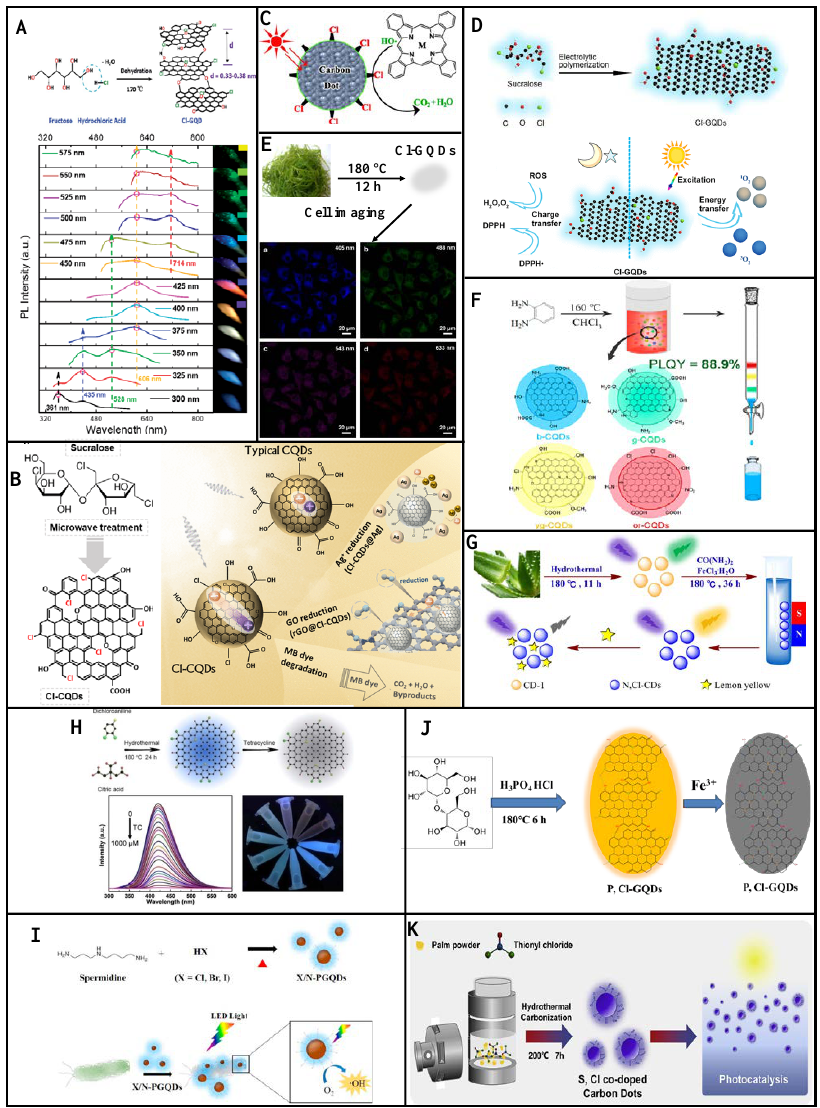
Figure 6. Synthesis and applications of Cl-doped CDs [79,83]. ( A ) Multicolor fluorescent Cl-GQDs were synthesized using fructose and hydrochloric acid as raw materials. ( B ) Microwave synthesis of Cl-CQDs by sucralose can be used for photocatalytic reduction and degradation of dyes. ( C ) Cl-CDs synthesized by the chlorine radical substitution reaction can rapidly photodegrade phenol cya- nine. ( D ) The synthesis of Cl-GQDs by electrochemical oxidation showed good antioxidant activity. ( E ) Using seagrass as raw material, white Cl-GQDs were synthesized using the hydrothermal method for application in multicolor cell imaging. ( F ) Cl-CQDs were obtained by the solvothermal reaction of o -phenylenediamine under trichloromethane, and fluorescent Cl-CQDs in four colors were obtained by column separation. ( G ) N and Cl-CDs were synthesized from aloe vera, and tartrazine in beverages can be detected based on FRET. ( H ) The hydrothermal synthesis of NCl-GQDs using citric acid and 3,4-dichloroaniline allows for the highly sensitive detection of tetracycline. ( I ) Schematic of the syn- thesis pathway of X/N-PGQDs with excellent sterilization activity under visible light. ( J ) PCl-CQDs were obtained by hydrothermal synthesis of maltose, phosphoric acid, and hydrochloric acid,